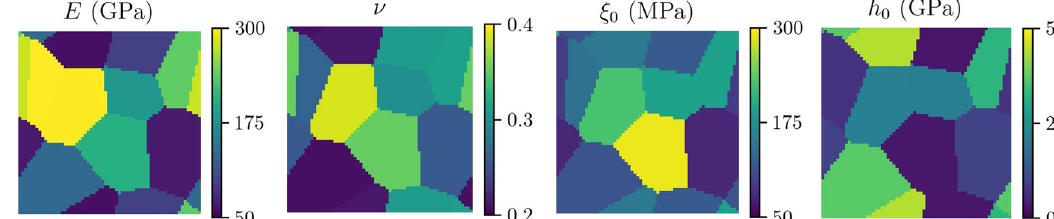
Fig. 9 Example of a randomly generated grain microstructure and corresponding material property distribution. The latter include Young ’ s modulus E , Poisson ’ s ratio ν , the initial fl ow resistance ξ 0 , and the linear isotropic hardening modulus h 0 .